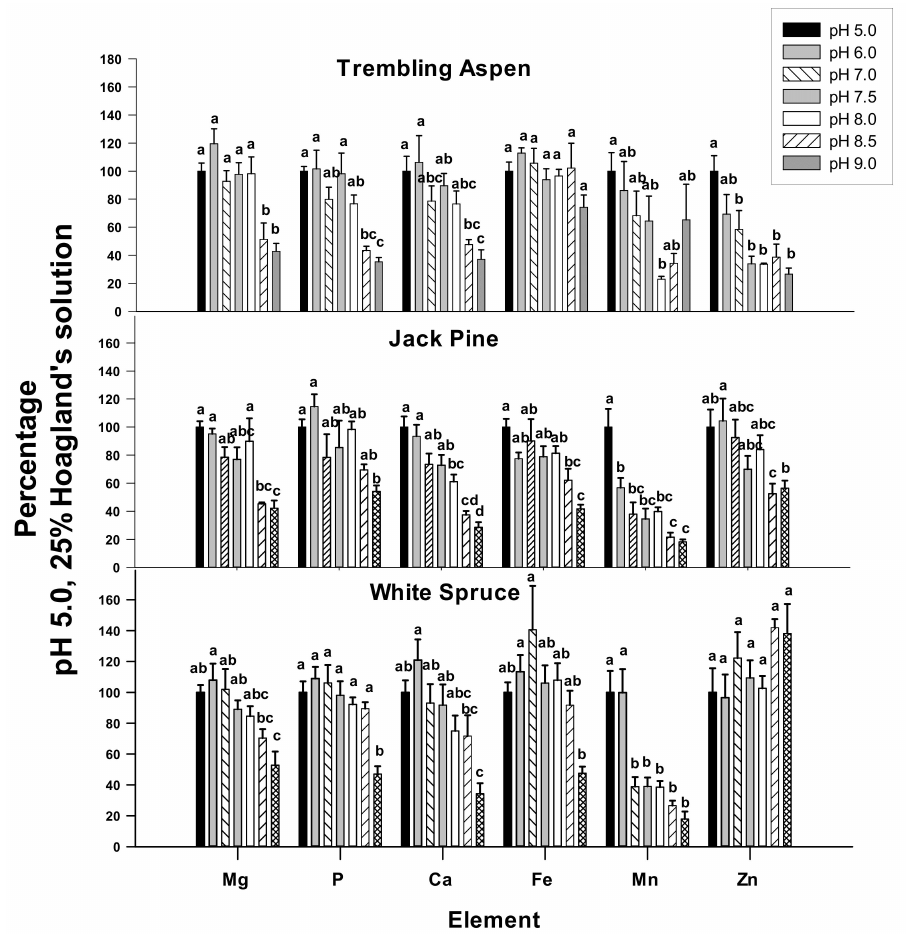
Figure 4. E ff ects of pH on Mg, P, Ca, Fe, Mn, and Zn concentrations in young foliage of plants supplied with 25% Hoagland’s solution, presented as the percentages of values measured at pH 5.0. Di ff erent letters above the bars indicate significant di ff erences ( α = 0.05) between treatments within each plant species. Means ( n = 6) ± SE are